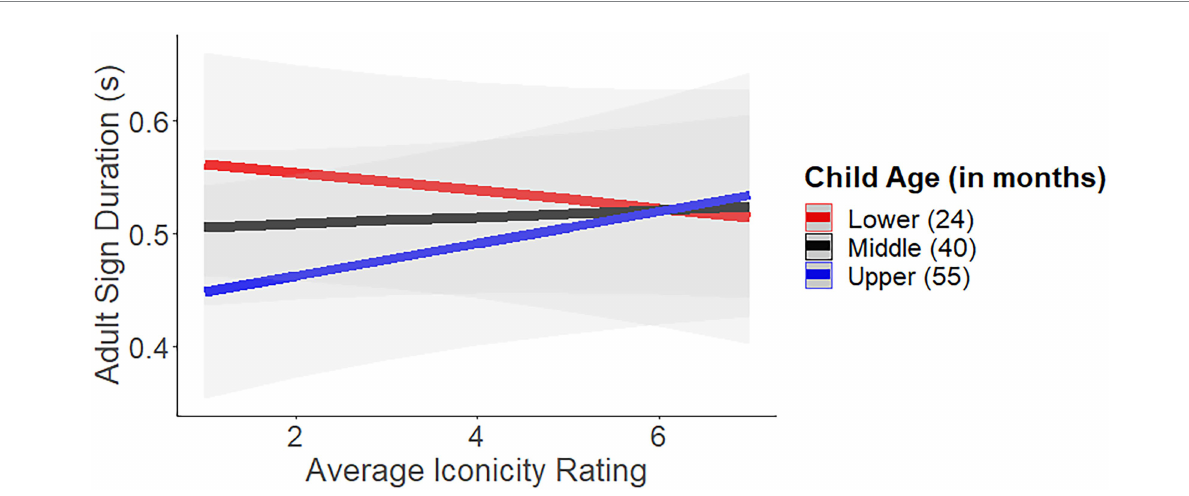
FIGURE 2 The interaction between sign duration, iconicity and child age in months. For younger and middle-aged children sign duration was similar regardless of the sign’s iconicity rating, but for older children sign duration was shorter for non-iconic signs than iconic signs. The lines indicate the children’s mean age and +/ − one standard